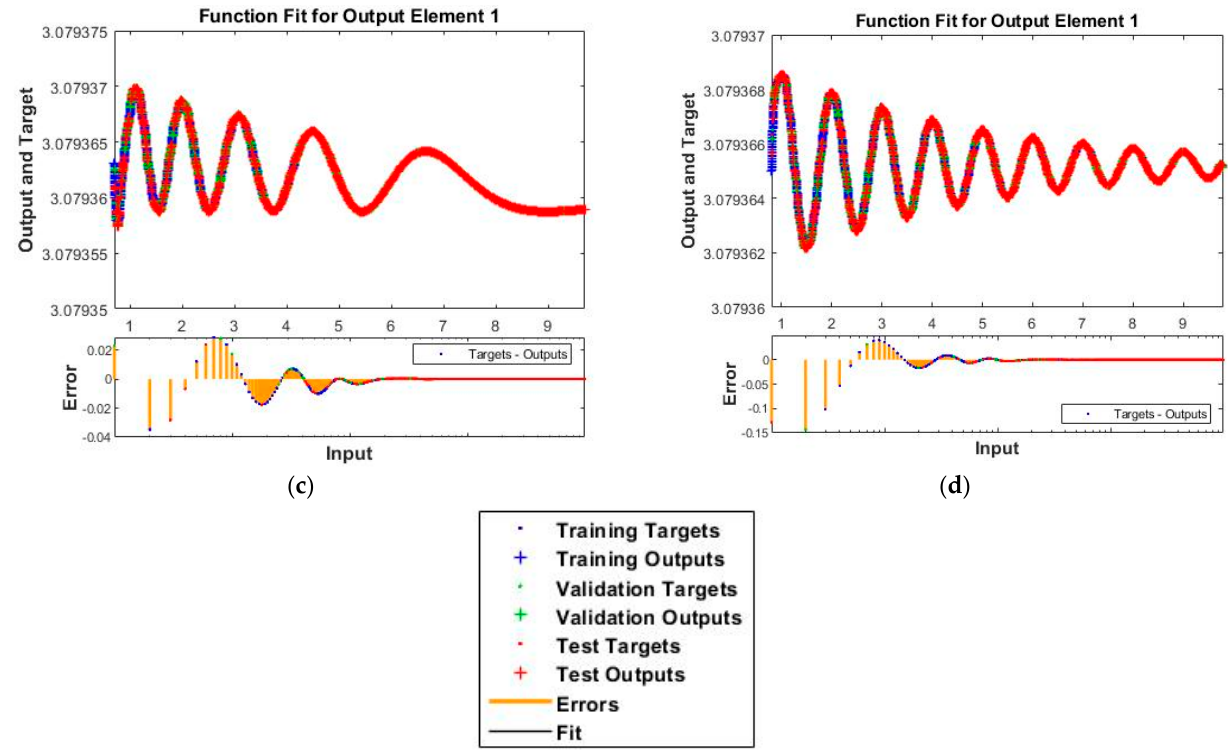
Figure 7. Function fitness curves for target, output elements, and error of all four cases of LMM-NNs for piezoelectric actuator. ( a ) LMM_NNs Case 1. ( b ) LMM_NNs Case 2. ( c ) LMM-NNs Case 3. ( d ) LMM-NNs Case 4.